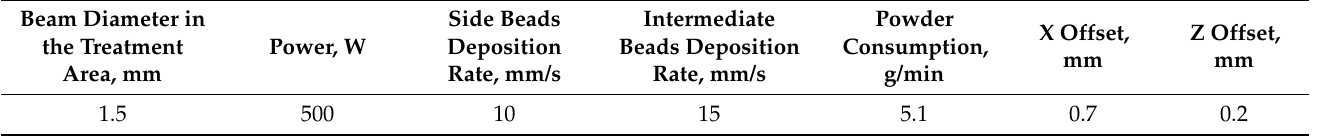
Table 2. Direct laser growth parameters.